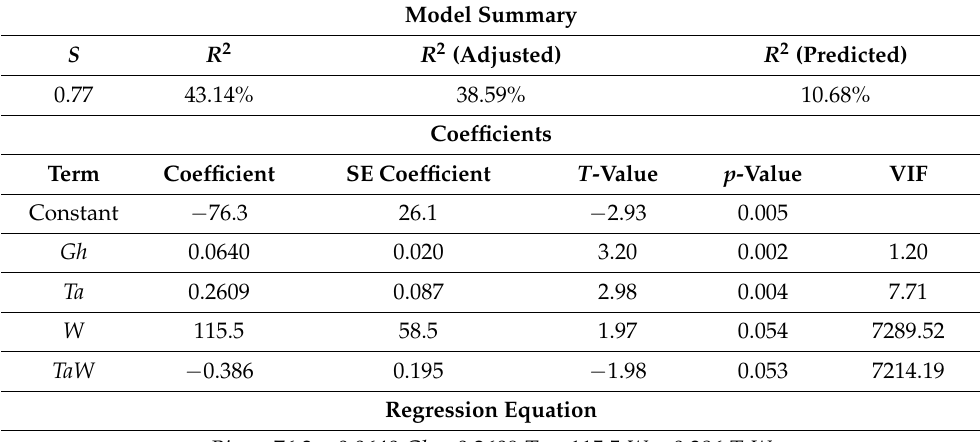
Table 3. Model summary for con-still (Model